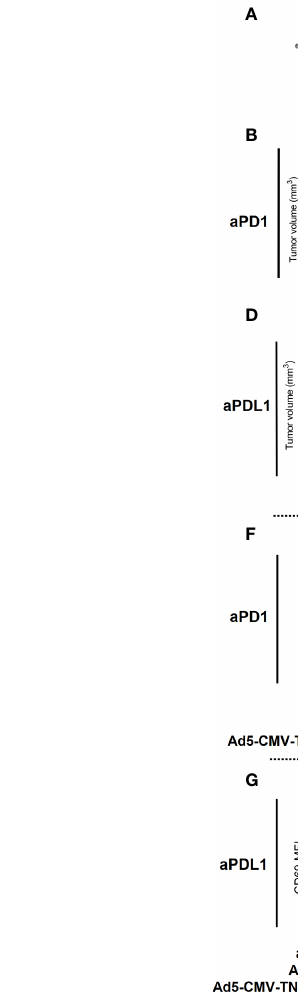
FIGURE 2 | Non-replicative Ad5-CMV-mTNF a /mIL-2 improves the anti-tumor response in ICI refractory MOC1 tumors and continued ICI treatment is bene fi cial to the response. (A) Experiment design. C57BL/6J mice (n = 7-10 per group) were subcutaneously injected with MOC1 cells into the right fl ank. When tumors reached 4-5mm then 100ug of either anti-PD-1 or anti-PD-L1 was injected every three days intraperitoneally. When tumors progressed over 8mm, animals were assigned to a group where they were treated with either continued anti-PD-1/PD-L1, with 1 × 10 9 VPs (non-replicative Ad5-CMV-mTNF a /mIL-2) intratumorally, or in combination. An additional virus backbone control group (Ad5-Luc) was included for immune cell analysis. Treatment frequency as indicated. (B, D) Individual tumor growth curves and Kaplan – Meier survival analysis for b anti-PD-1 and d anti-PD-L1 refractory. (C, E) Corresponding treatment group tumor derived CD3 + cytotoxic functional analysis measured by mGranzyme B and mIFN-y dual-ELISpot. (F, G) Flow cytometric analysis of T cell activation markers from MOC1 (upper panel anti-PD-1, lower panel anti-PD-L1) refractory tumors digests. In vitro and ex vivo data sets were evaluated for statistical signi fi cance by non-parametric unpaired t test and survival curves by Mantel – Cox log-rank test respectively. All data are shown as means ± SEM and signi fi cance is represented as *p < 0.05, **p < 0.01, ***p < 0.001, ns, not signi fi